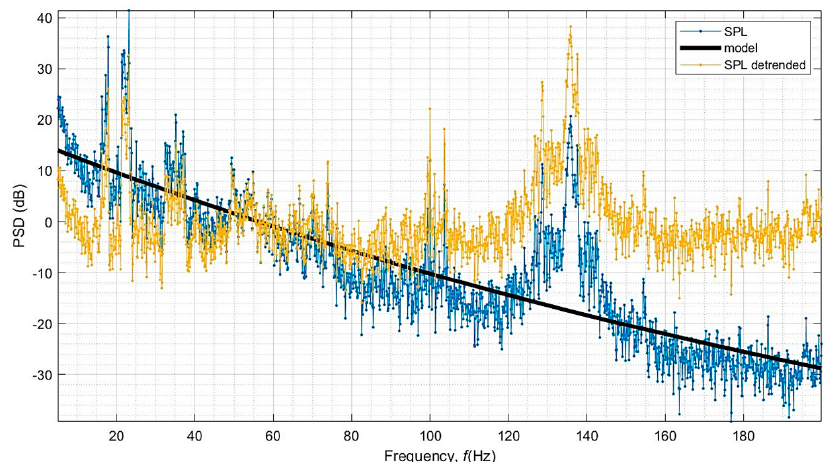
Figure 13. Example of a PSD distribution from a one-minute SPL -referenced signal, trend line calculated using the model and the corresponding detrended signal. Frequency range up to 200 Hz.